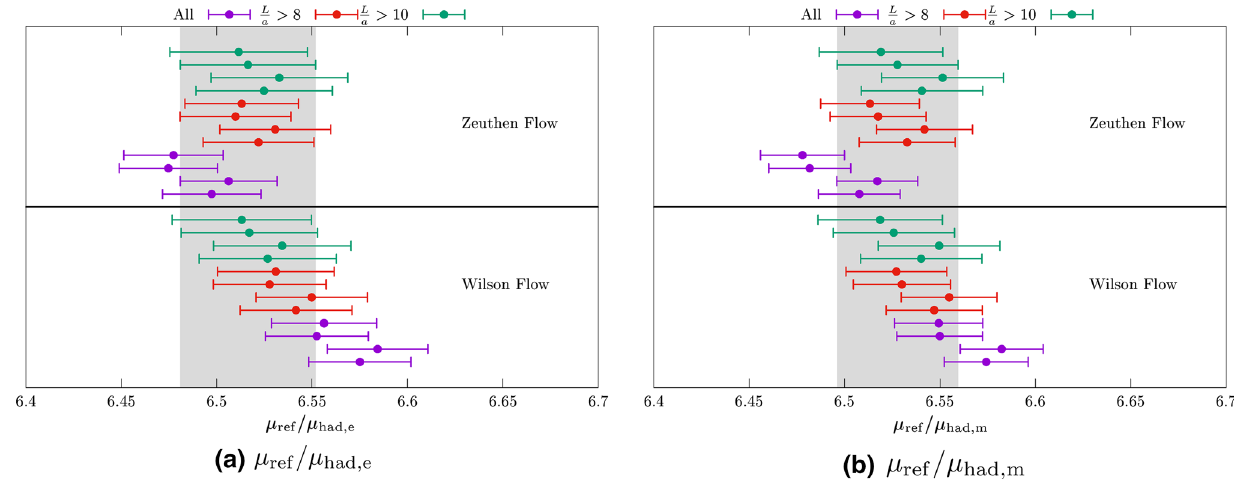
Fig. 6 Results for the ratios μ ref /μ had , e and μ ref /μ had , m . The different analysis correspond to different choices of discretization (labelled Zeuthen and Wilson), parametrizations of the β -function and cuts on the lattice resolutions (see text for more details) Table 4 Results for t 0 / a 2 and r 0 / a for different values of β .